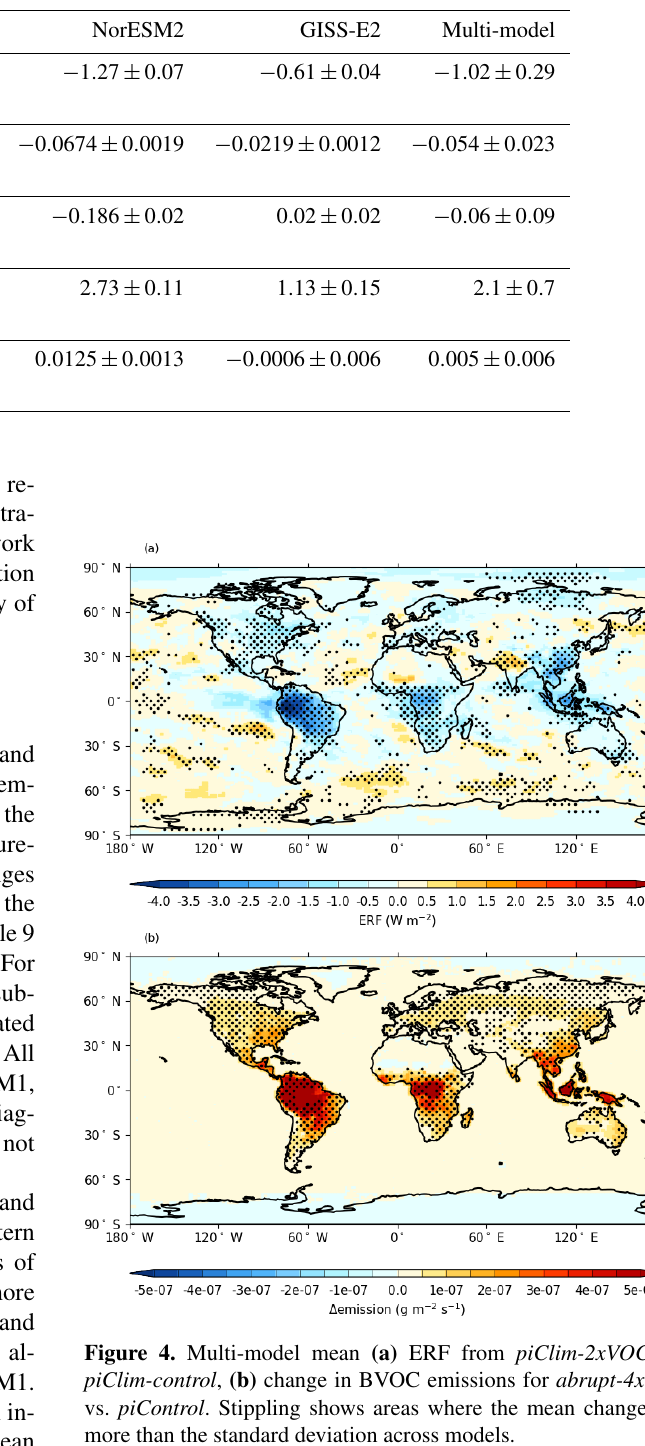
Table 8. Radiative efficiencies by emissions from 2xDMS . Changes in emissions are from the 4xCO2 experiment. α values are calculated assuming ERF is proportional to emissions. Uncertainties for each model are errors in the mean based on interannual variability. Uncertainties in the multi-model results are the standard deviation across the models. The multi-model α terms are the average of the individual model α rather than the product of the multi-model φ and γ .